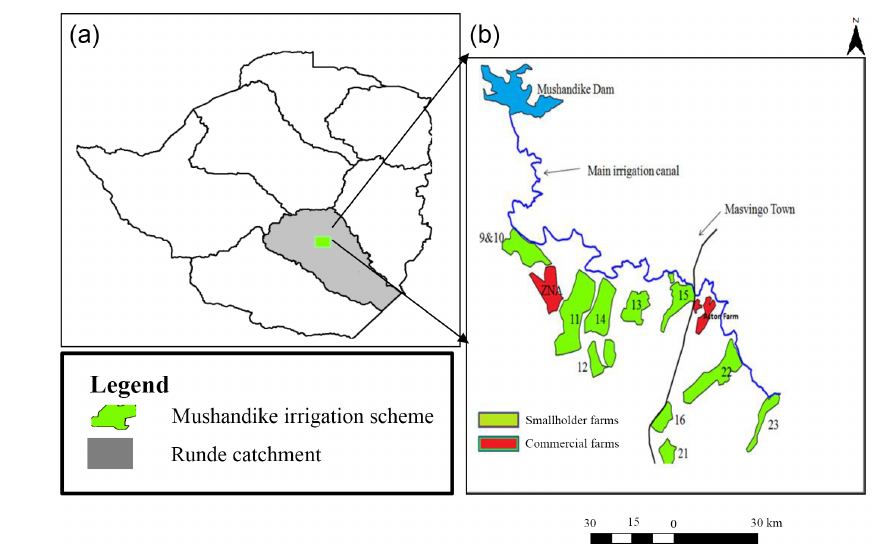
Figure 1. (a) Location of Mushandike Irrigation Scheme (b) Layout of Mushandike Irrigation